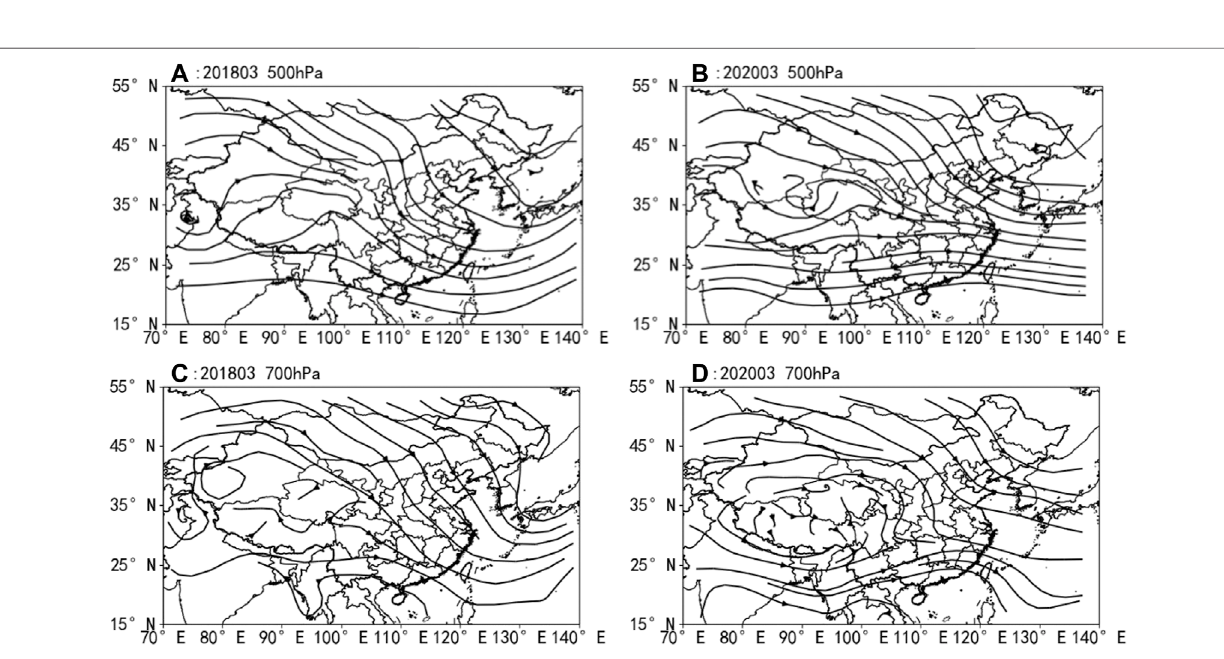
Frontiers in Environmental Science |